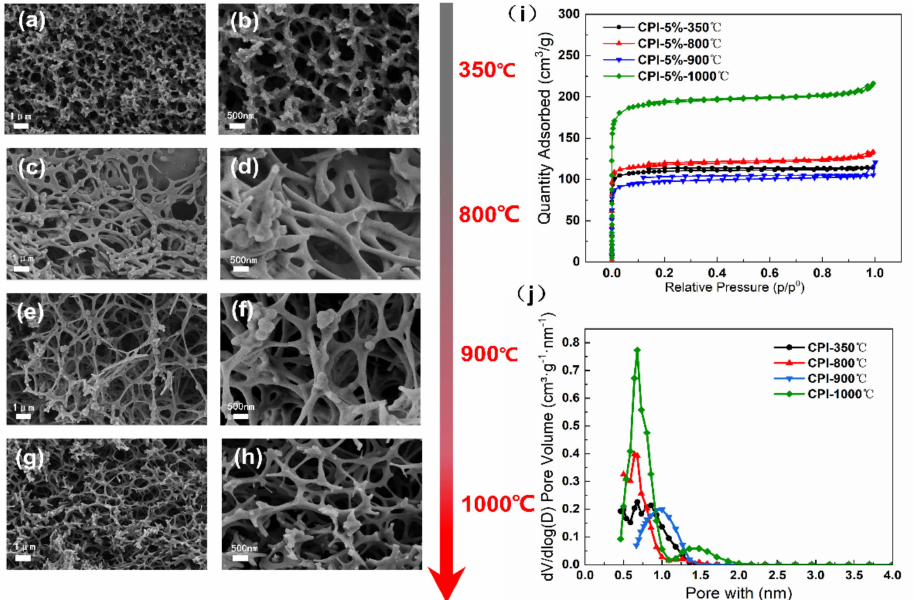
Figure 2. SEM images of the morphology of the aerogels: ( a , b ) CPI-350 ◦ C, ( c , d ) CPI-800 ◦ C, ( e , f ), CPI-900 ◦ C, and ( g , h ) CPI-1000 ◦ C; ( i ) N 2 adsorption–desorption isotherms, ( j ) BJH desorption d V /dlog ( D ) pore volume of